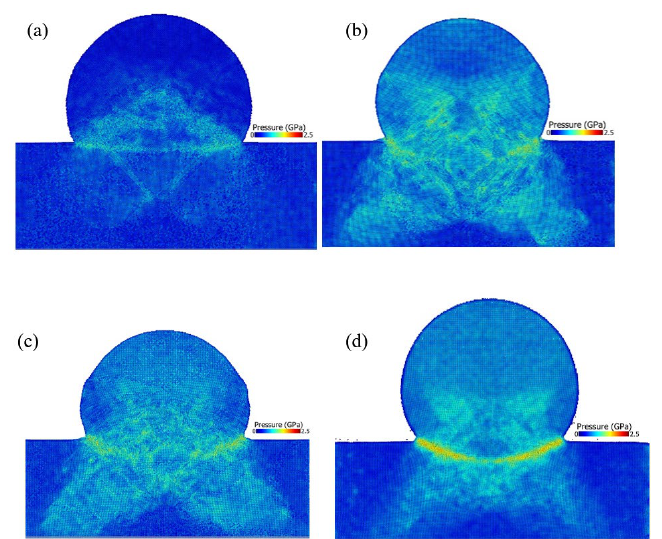
Figure 3. Splat morphologies of different material combination at 20 ps: ( a ) Al/Cu (showing no jet) for the whole simulation period ( b ) Cu/Cu, ( c ) Ni/Cu, and ( d ) Ag/Cu (b-c showing jet initiation) for 273 K.